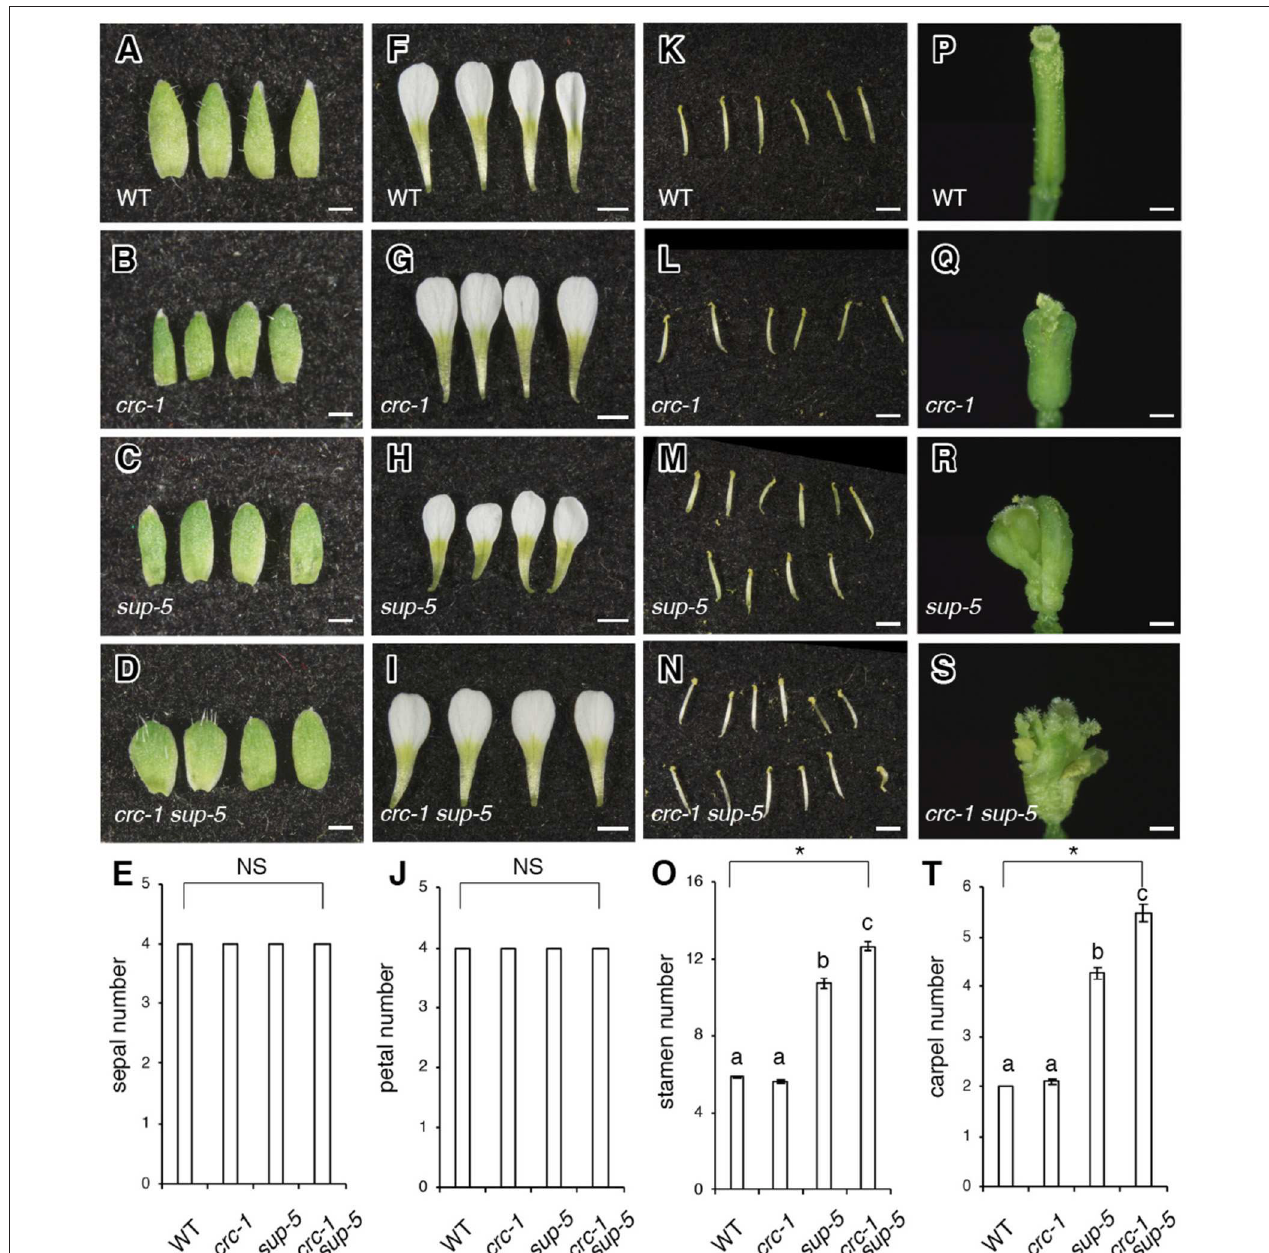
FIGURE 2 | Comparison of floral organ number among the wild type, crc-1 , sup-5 , and sup-5 crc-1 at floral stage 13. (A–D) Side view of sepals. (A) The wild type (WT), (B) crc-1 , (C) sup-5 , and (D) crc-1 sup-5 . Scale bars represent 500 µ m. (E) Quantification of sepal number. (F–I) Side view of petals. (F) The wild type, (G) crc-1 , (H) sup-5 , and (I) crc-1 sup-5 . Scale bars represent 1mm. (J) Quantification of petal number. (K–N) Side view of stamens. (K) Wild type, (L) crc-1 , (M) sup-5 , and (N) crc-1 sup-5 . Scale bars represent 1mm. (O) Quantification of stamen number. (P–S) Side view of carpels. (P) The wild type, (Q) crc-1 , (R) sup-5 , and (S) crc-1 sup-5 . Scale bars represent 500 µ m. (T) Quantification of carpel number. Mean ± SEM are shown. Scale bars represent 500 µ m. Asterisks indicate significant differences based on one-way ANOVA. The same letters indicate non-significant differences, whereas different letters indicate significant differences based on the post-hoc Tukey HSD test ( p <